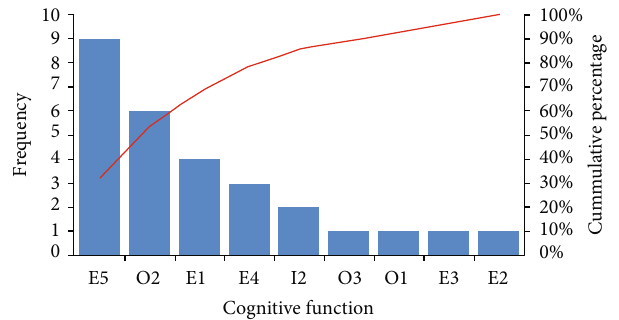
Figure 5: Pareto chart of cognitive